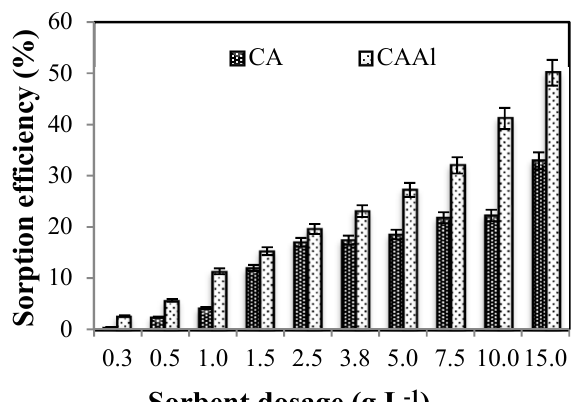
Figure 4 plots the isotherm curves of boron: the isotherms are critical to characterize the optimal conditions of the process, and these allow the distribution of the sorbate between the liquid and solid phases at equilibrium to be described [42]. The curves indicate the appearance of a typical